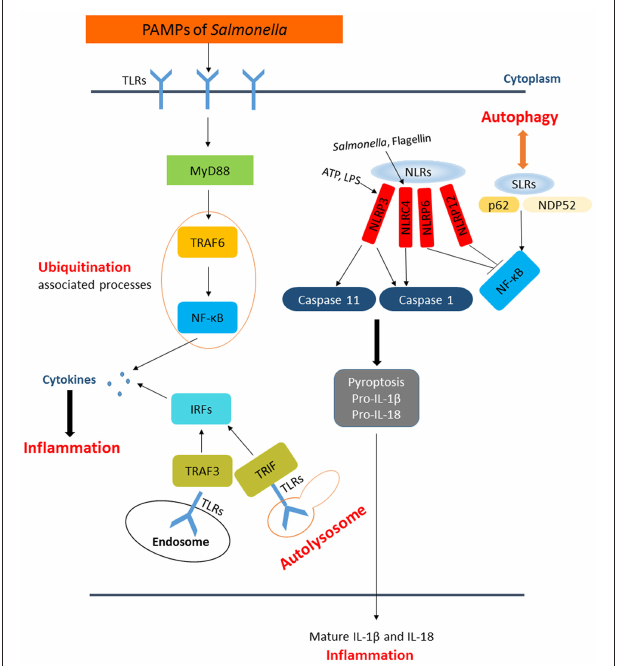
FIGURE 3 | The paradigm of host inflammation responses to Salmonella and its interaction with autophagy as well as ubiquitination. PAMPs from Salmonella are recognized by membrane-bound TLRs in the extracellular space and within endosomes. The recognition of TLRs activate NF- κ B and interferon-regulatory factors pathway to produce pro-inflammatory cytokines responding to Salmonellae . SLRs and NLRs are PRRs in the cytosol detecting intracellular pathogens. SLRs not only enable autophagy to degrade bacteria but also act as an inflammatory signaling platform. The activation of inflammasomes, which consist of caspase-1, NLRs, etc., can affect the inflammation in cytosol directly. NLRP3 and NLRC4 can lead to processing of caspase-1 or caspase-11, followed by secretion of pro-IL-1 β and pro-IL-18 resulting in pyroptosis. NLRP6 and NLRP12 are also activated by Salmonella through unknown ligands that inhibiting NF- κ B